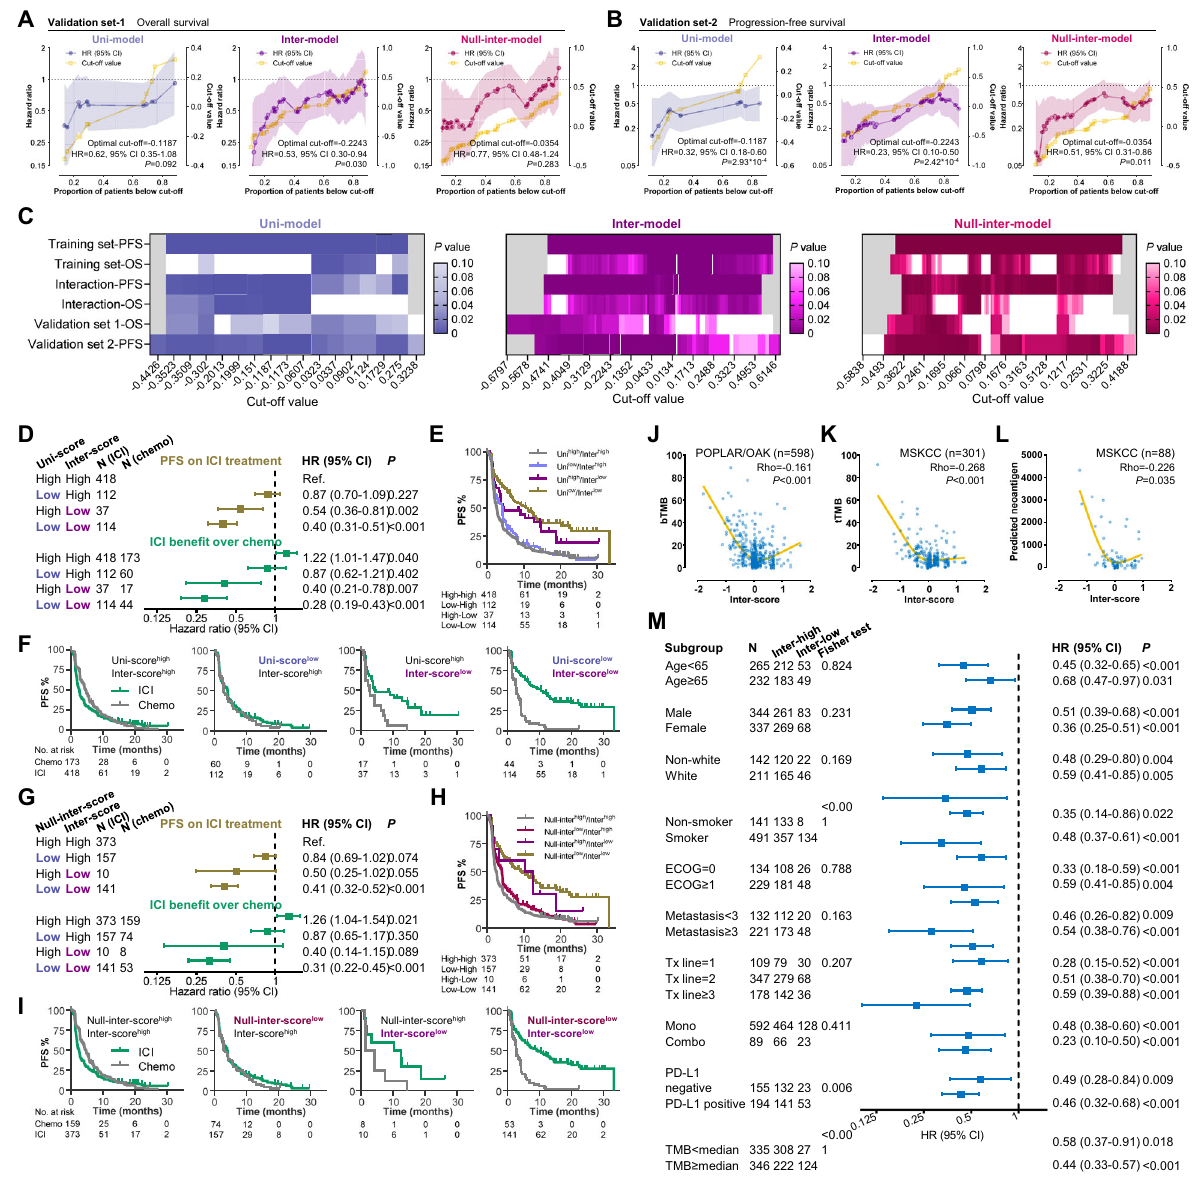
Fig. 3 Validation and comparison of the three models and potential immune-related mechanism of the inter-score in nonsquamous NSCLC. A , B Performances of the three models on discriminating the OS on anti-PD-(L)1 monotherapy in the validation set-1 ( A ) and the PFS on combination therapy with anti-CTLA-4 in the validation set-2 ( B ). C Summary of the performances of the three models in all training/ validation sets. D – F Comparison between the uni-model and the inter-model when two results are inconsistent ( D ). KM curves illustrating PFS on ICI treatment ( E ) and PFS bene fi t from ICI therapy over docetaxel ( F ). G – I Comparison between the null-inter-model and the inter-model when two results are inconsistent ( G ). KM curves illustrating PFS on ICI treatment ( H ) and PFS bene fi t from ICI therapy over docetaxel ( I ). J – L Association of the inter-score with blood TMB ( J ), tissue TMB ( K ), and neoantigen load ( L ). M Effectiveness of the inter-score in patients with different clinicopathological features, TMB, and PD-L1. Abbreviations: CTLA-4 cytotoxic T lymphocyte antigen-4, ICI immune checkpoint inhibitor, KM Kaplan-Meier, NSCLC nonsmall cell lung cancer, OS overall survival, PD-1 programmed death-1, PD-L1 programmed death-ligand 1, PFS progression-free survival, TMB tumor mutational survival outcomes (all HR and 95% CI results below are summarized in Fig. 3D). To start with, we compared the inter-model with the uni-model. As shown in Fig. 3E illustrating the PFS on ICI treatment, the uni-score high /inter-score high subgroup had the shortest PFS. Compared to this subgroup, slightly longer PFS was observed in the uni-score low /inter-score high subgroup (HR = 0.87, 95% CI 0.70 – 1.29, P = 0.227), but markedly longer PFS was revealed in the uni-score high /inter-score low subgroup (HR = 0.54, 95% CI 0.36 – 0.81, P = 0.002). As shown in Fig. 3F, compared to